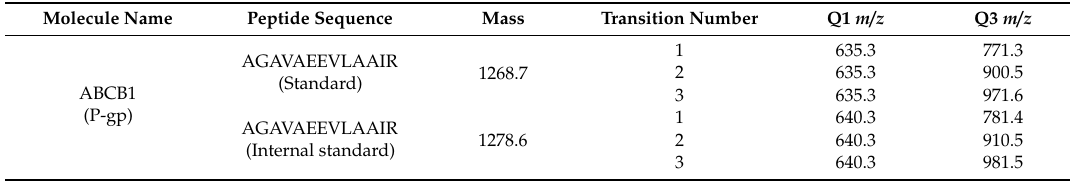
Table 1. Tryptic proteospecific peptide and its respective ions and mass transitions used for P-gp absolute quantification (*isotope-labelled amino acid, the labelling of Arg (R) was done by introducing C 13 and N 15